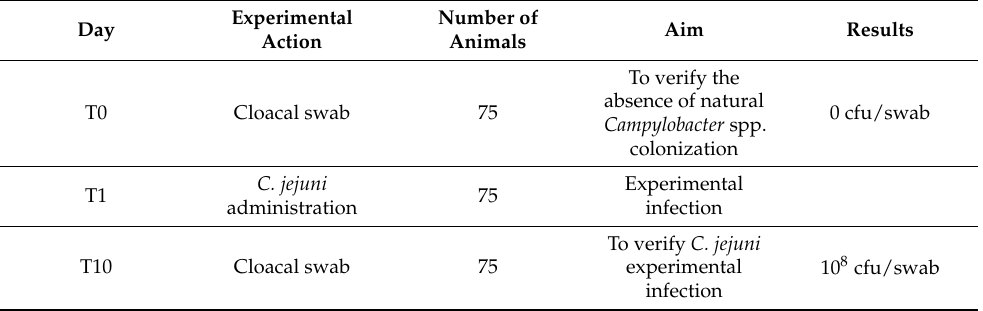
Table 3. Experimental design of the in vivo trial, including time (T), aim of the action, and results.